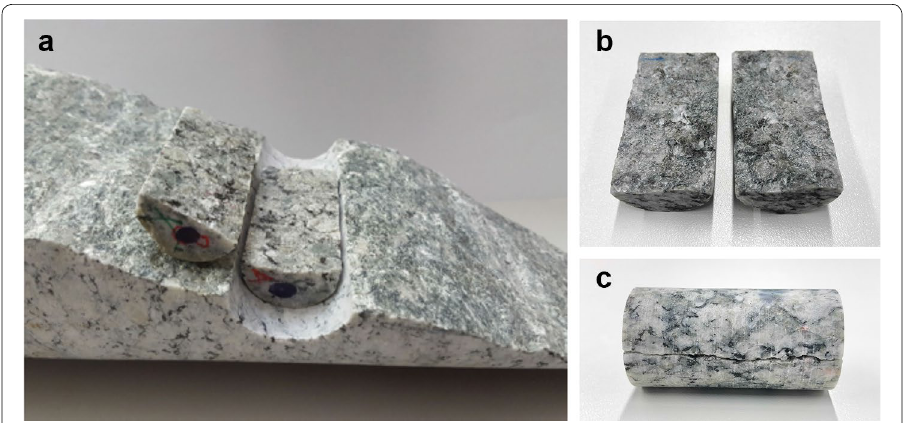
Fig. 2 Naturally fractured granodiorite specimens. a Example of an over‑cored specimen on top of one fracture surface (reprinted from Vogler et al. 2016 with the permission of the copyright owner); b Specimen N14 with the fracture surfaces opened and c